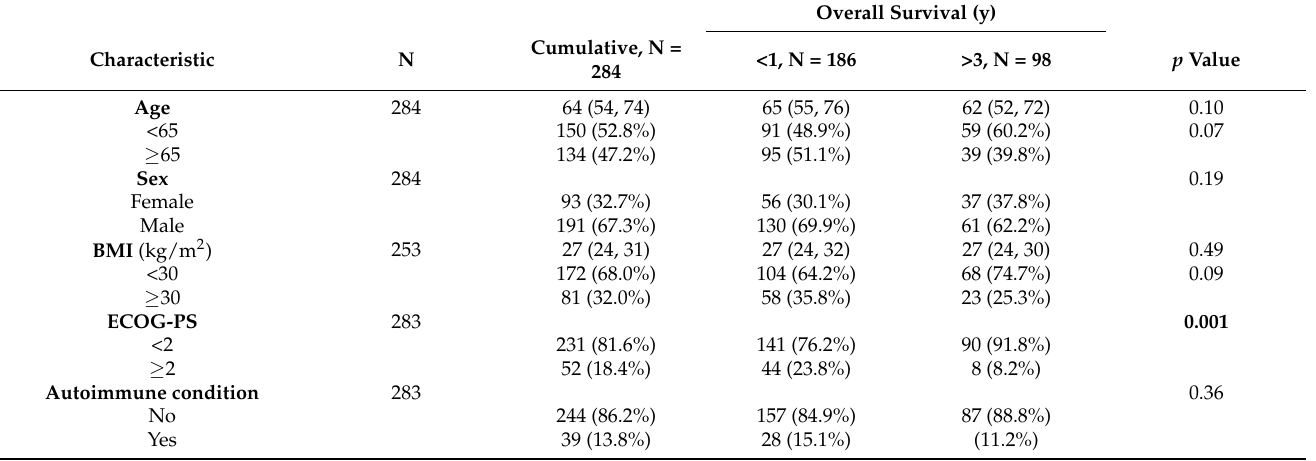
Table 1. Baseline demographic and clinical characteristics of the patient cohort excluding patients with survival between 1–3 years ( n = 284